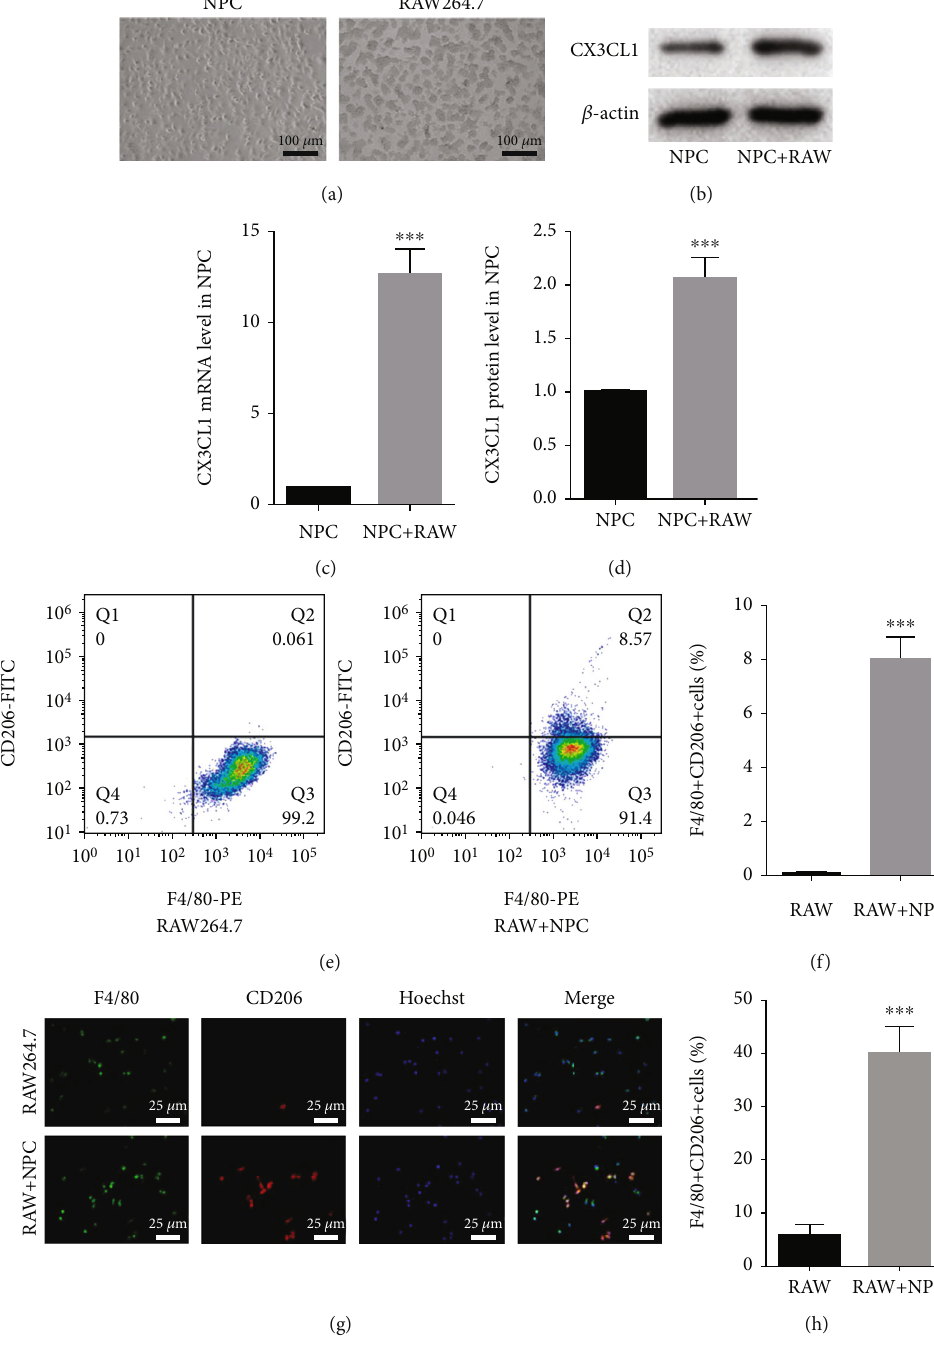
Figure 7: NPC were spindle in shape and were able to adhering to the wall, while the RAW264.7 macrophages were round in shape, well clustered, and also able to adhering to the wall (a). In the coculture system, RAW264.7 signi fi cantly increased the expression of CX3CL1 in NPC (b – d). Besides, NPC signi fi cantly induced M2 polarization of RAW264.7 as measured by fl ow cytometry (e, f) and immuno fl uorescent staining (g, h). “ ∗∗∗ ” indicates p < 0 : 001 . RAW: RAW264.7 macrophages. NPC: nucleus pulposus